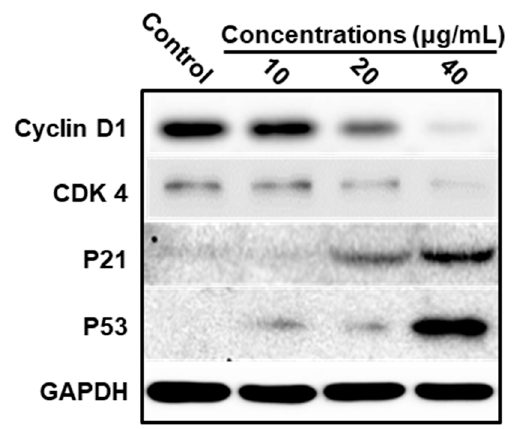
Figure 5. Western immunoblot analysis of the expressions of Cyclin D1, CDK4, P21, and P53 on DU145 cells. Cells were treated with LEGCG for 24 h.